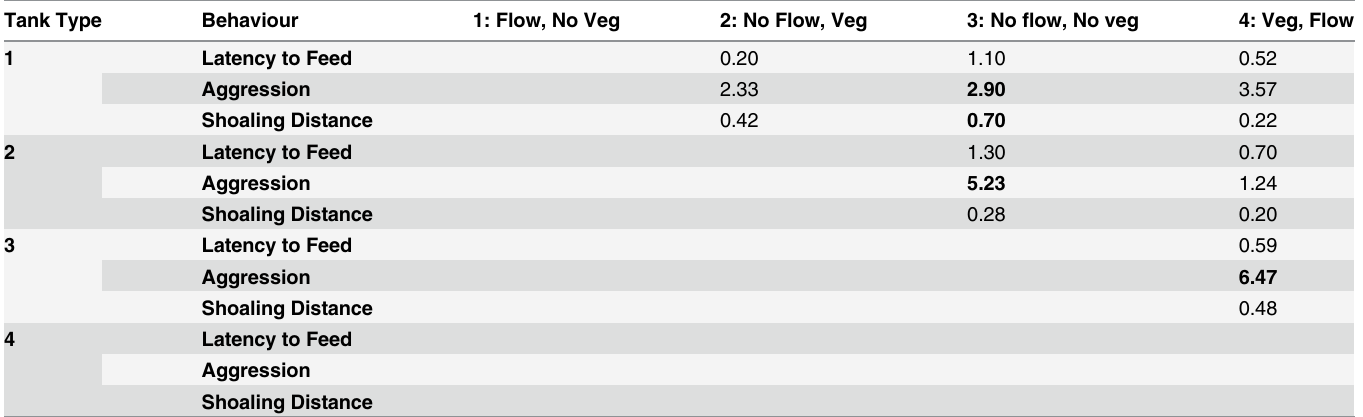
Table 5. Paired comparisons of mean differences across tank treatment types (1, 2, 3 and 4) for (log transformed) Latency to feed, (square-root transformed) Aggression and (log transformed) Shoaling distance measurements. Tank